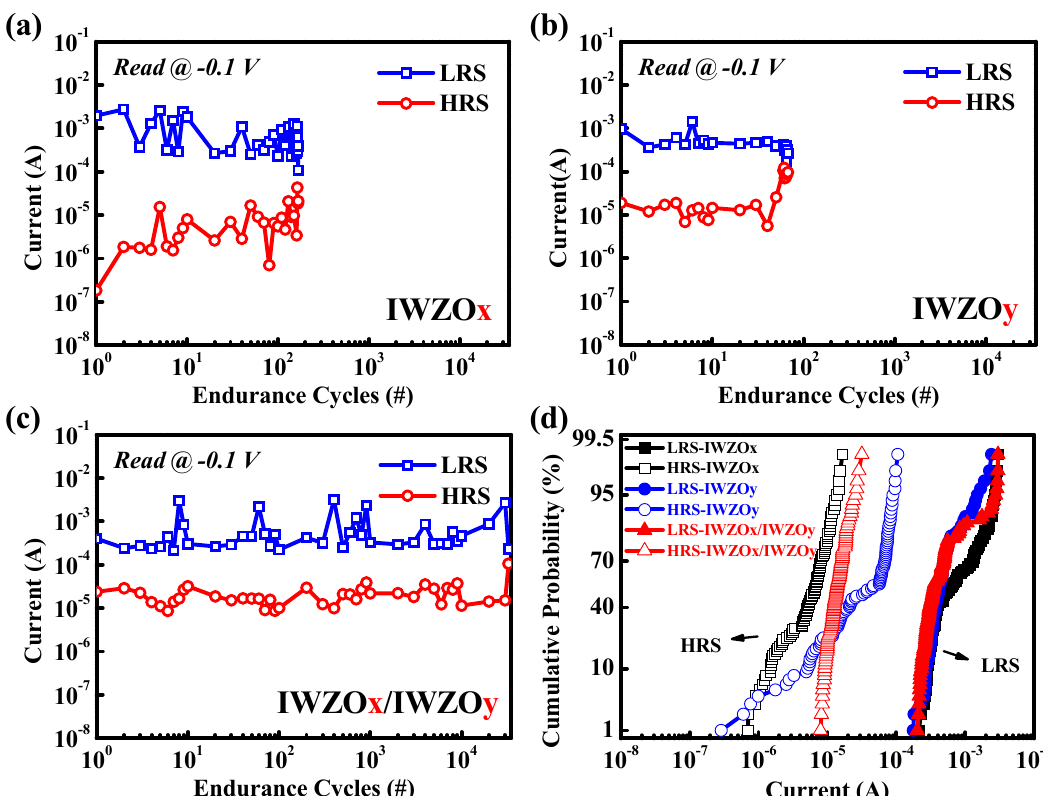
Figure 6. Endurance cycles of CBRAM devices with ( a ) IWZOx, ( b ) IWZOy, and ( c ) IWZOx/y switching layers; ( d ) cumulative distribution for LRS and HRS of CBRAM devices with different switching layers.